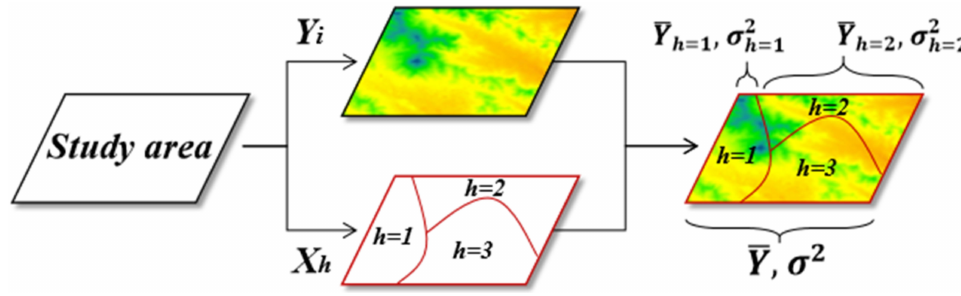
Figure 4. The principle of the geographical detector.